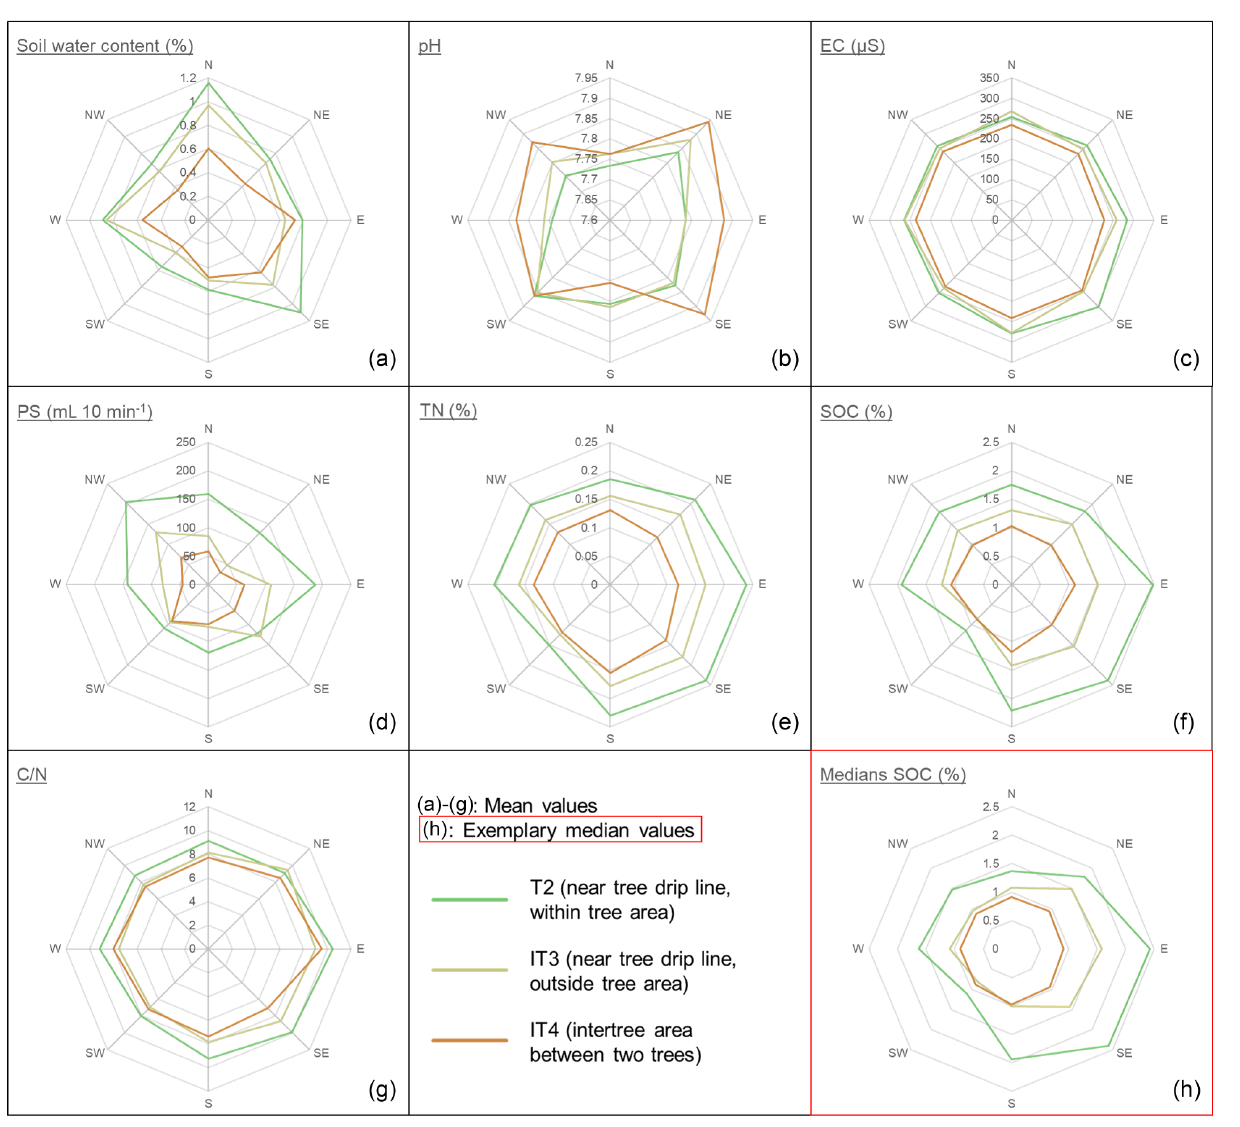
Figure 7. Spider charts showing the means for each direction and parameter and sampling location. (a) Mean soil water content. (b) Mean pH. (c) Mean electrical conductivity. (d) Mean percolation stability. (e) Mean total nitrogen content. (f) Mean content of soil organic carbon. (g) Mean C / N ratio. (h) Median content of soil organic